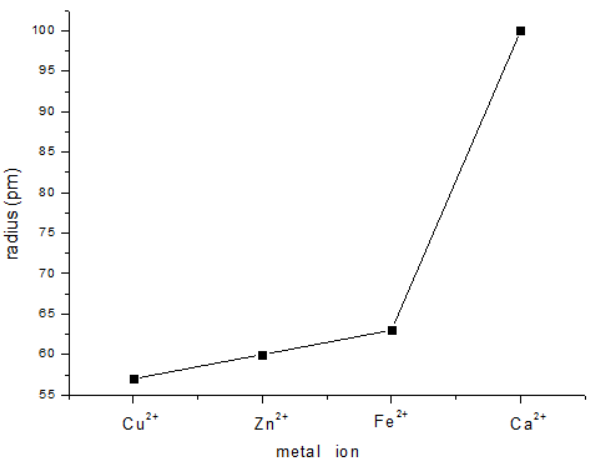
2 + , Zn 2 + , Fe 2 + , and Ca 2 +